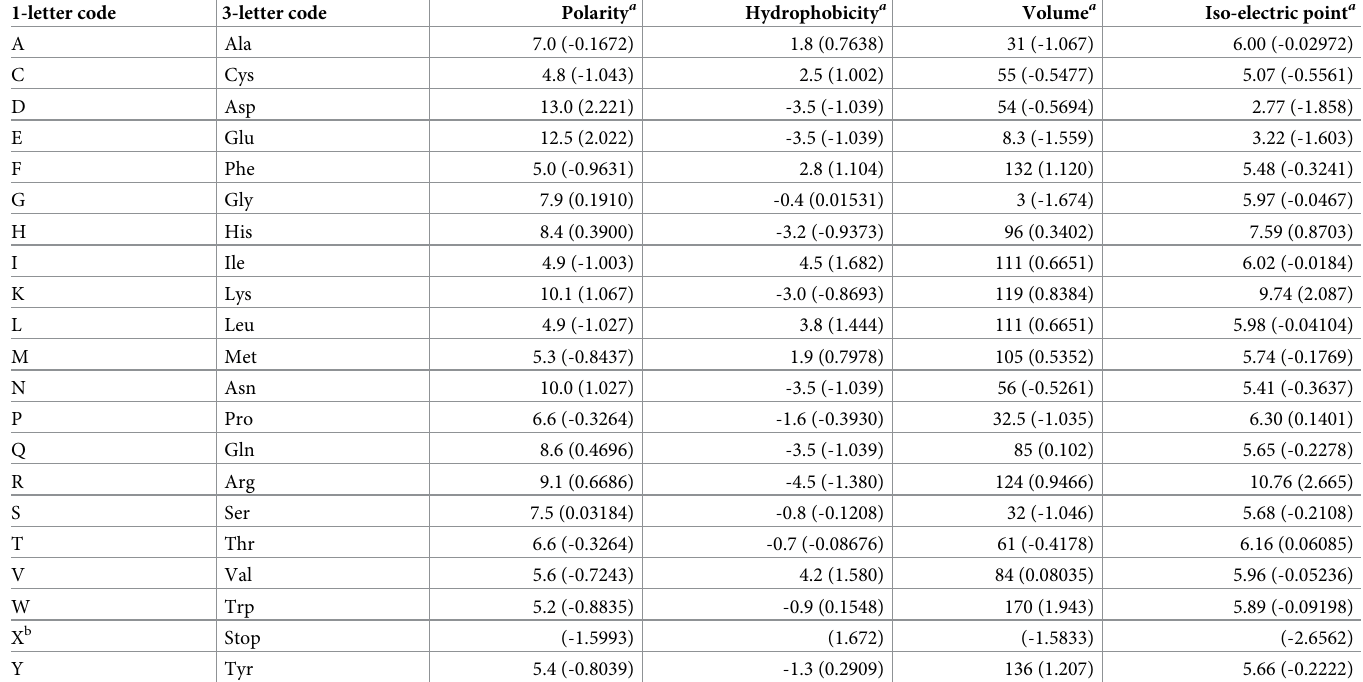
Table 1. Amino acid